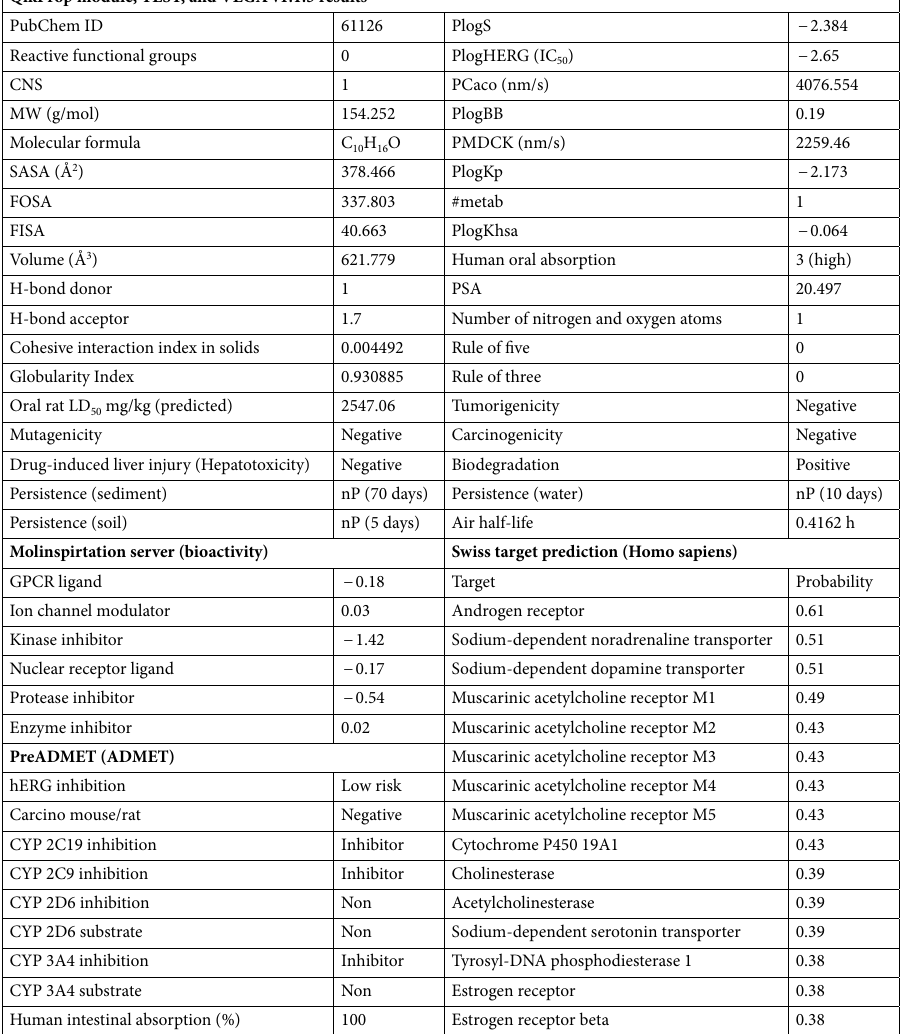
Table 1. ADMET profiling and ecological risk assessment. MW molecular weight, SASA total solvent accessible surface area, FOSA hydrophobic component of the SASA, FISA hydrophilic component of the SASA, PlogS predicted aqueous solubility (log S), PlogHERG predicted IC 50 value for blockage of HERG K + channels, PCaco predicted apparent Caco-2 cell permeability (model for the gut-blood barrier), PlogBB predicted brain/blood partition coefficient, PMDCK predicted apparent MDCK cell permeability, PlogKp predicted skin permeability (log Kp), PlogKhsa prediction of binding to human serum albumin, PSA Van der Waals surface area of polar nitrogen and oxygen atoms, Rule of five number of violations of Lipinski’s rule of five, #metab number of likely metabolic reactions, Rule of three number of violations of Jorgensen’s rule of three (PlogS > − 5.7, PCaco > 22 nm/s, #Primary Metabolites < 7), nP